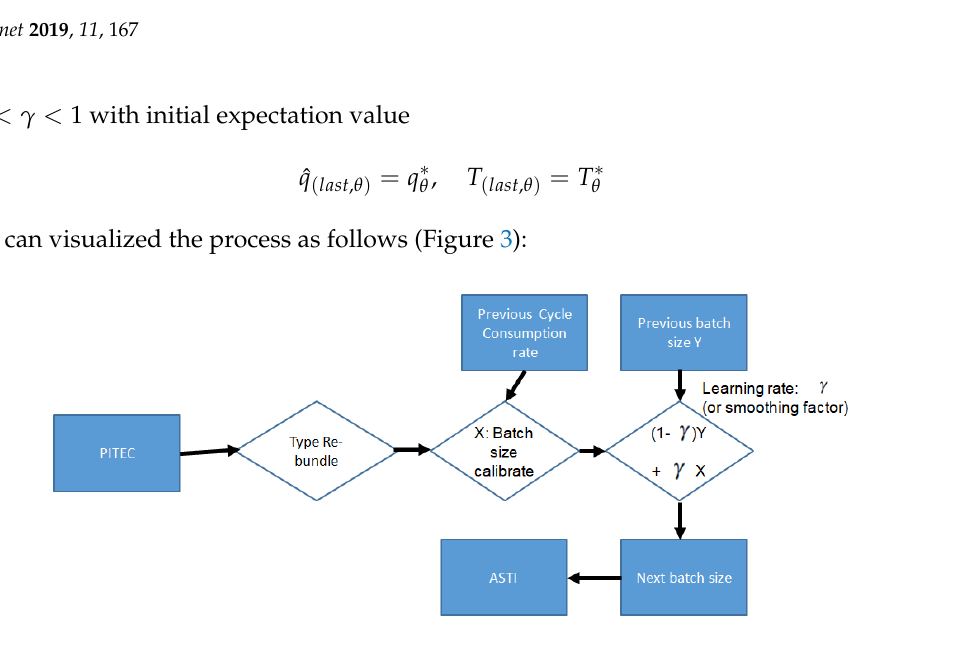
Figure 3. The ASTI process: smoothing factor